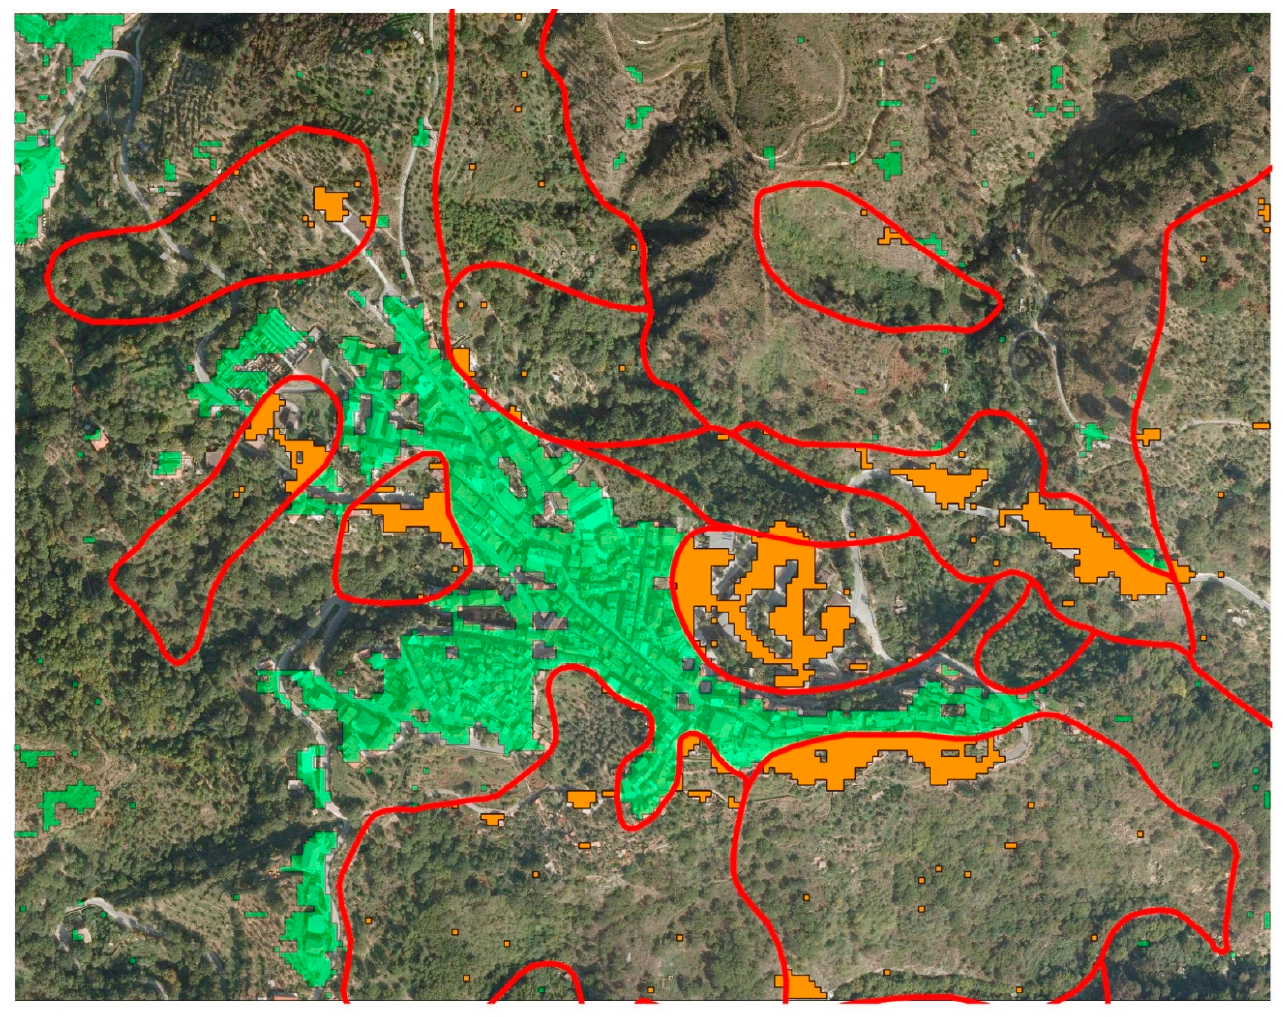
Figure 11. Predicted buildings’ mask and landslide risk zones delimitation in Petrizzi, represented in QGIS environment.